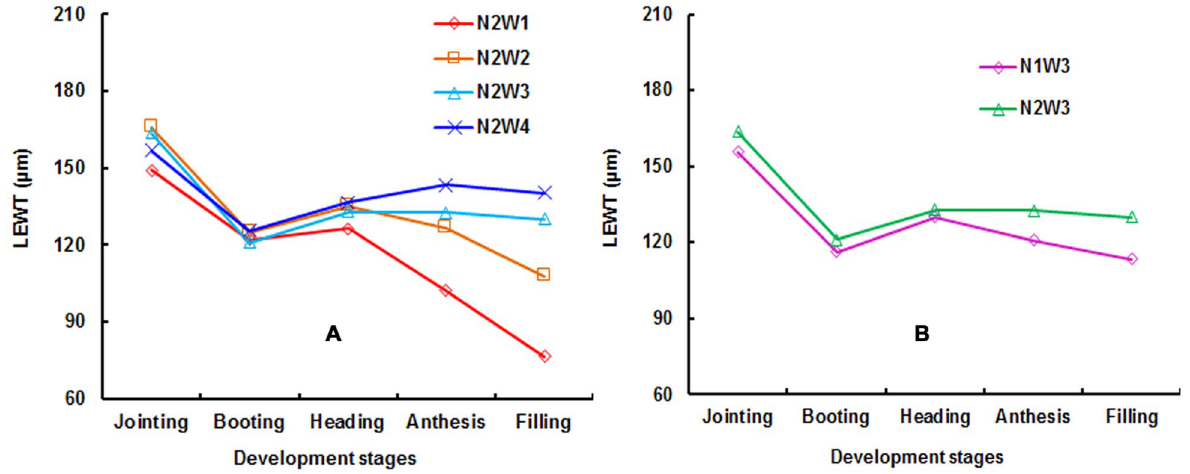
Figure 1. Changes of LEWT under different water treatments at N2 (A) and varied nitrogen treatments at W3 (B) in Exp. 1.